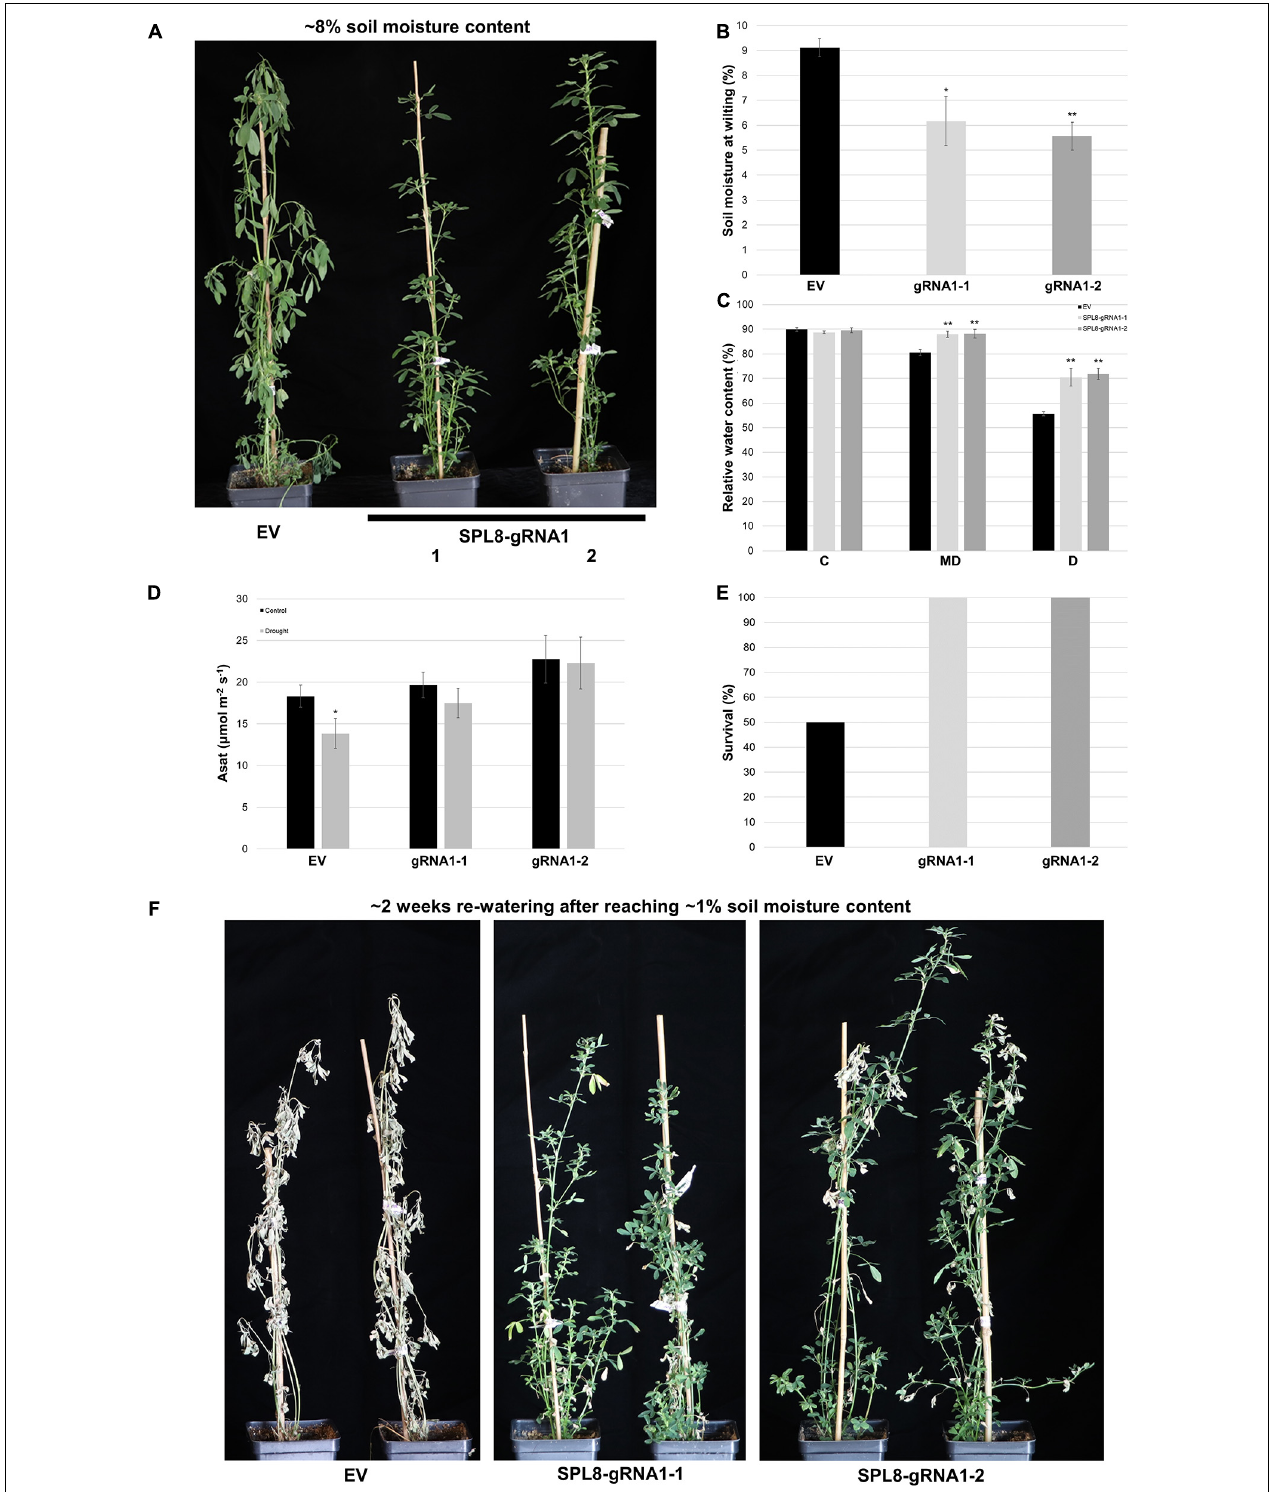
FIGURE 6 | Response of SPL8-gRNA1 and EV genotypes to drought stress. (A) Representative images of SPL8-gRNA1-1, SPL8-gRNA1-2 and EV genotypes after withholding water until volumetric soil moisture levels reached approximately 8%, 11 days after initiating the withholding of water. (B) Soil moisture level at which SPL8-gRNA1 and EV genotypes began to wilt. (C) Relative water content (RWC) of third fully expanded trifoliate leaves assessed when soil moisture contents were